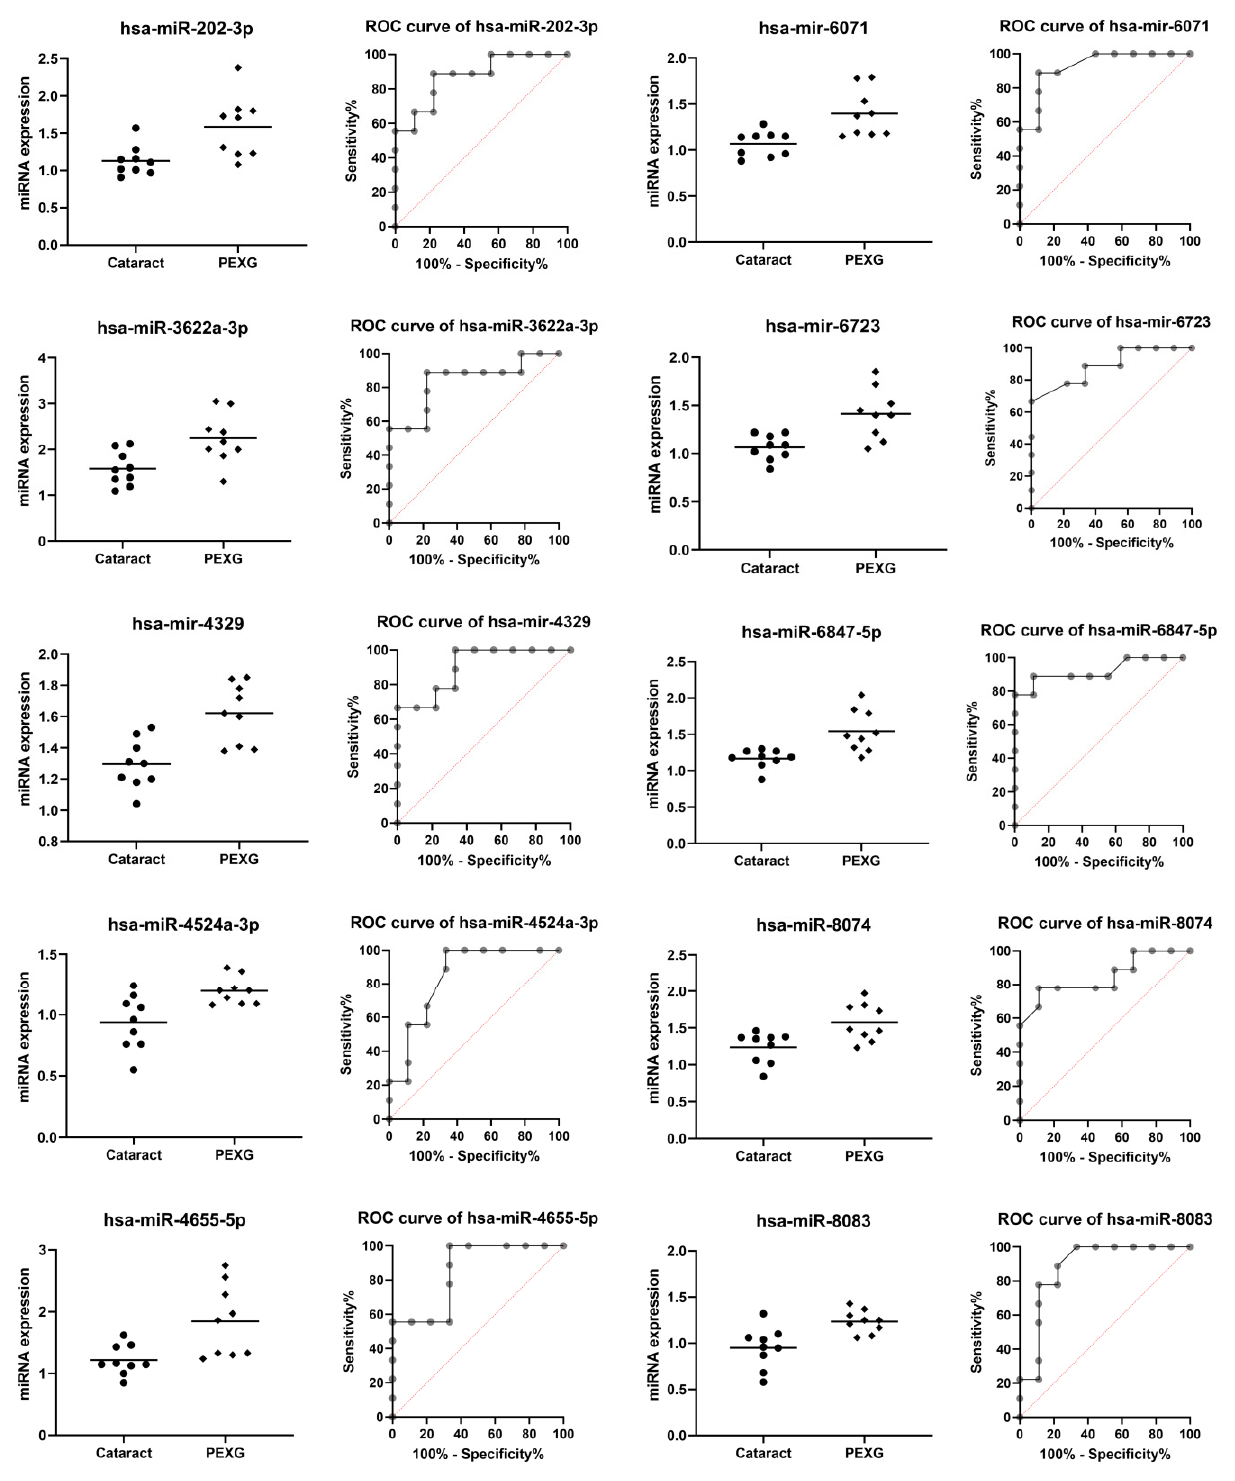
Figure 2. Higher miRNA expression in the PEXG group compared to the cataract group. Data are shown as mean [log2].